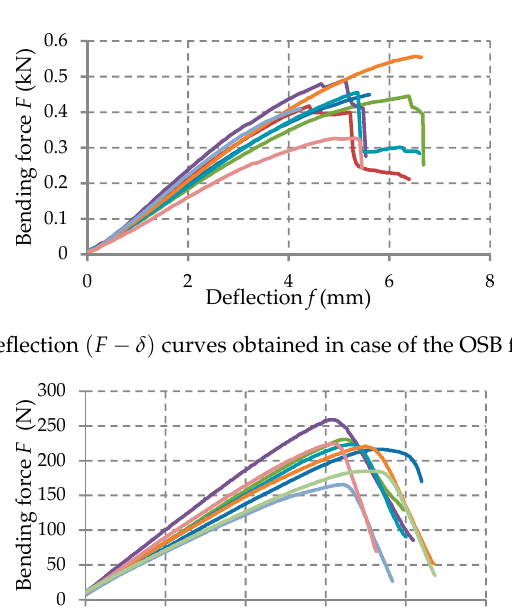
( ) δ− Figure 10. Force–deflection F curves obtained in case of the OSB flexural specimens.